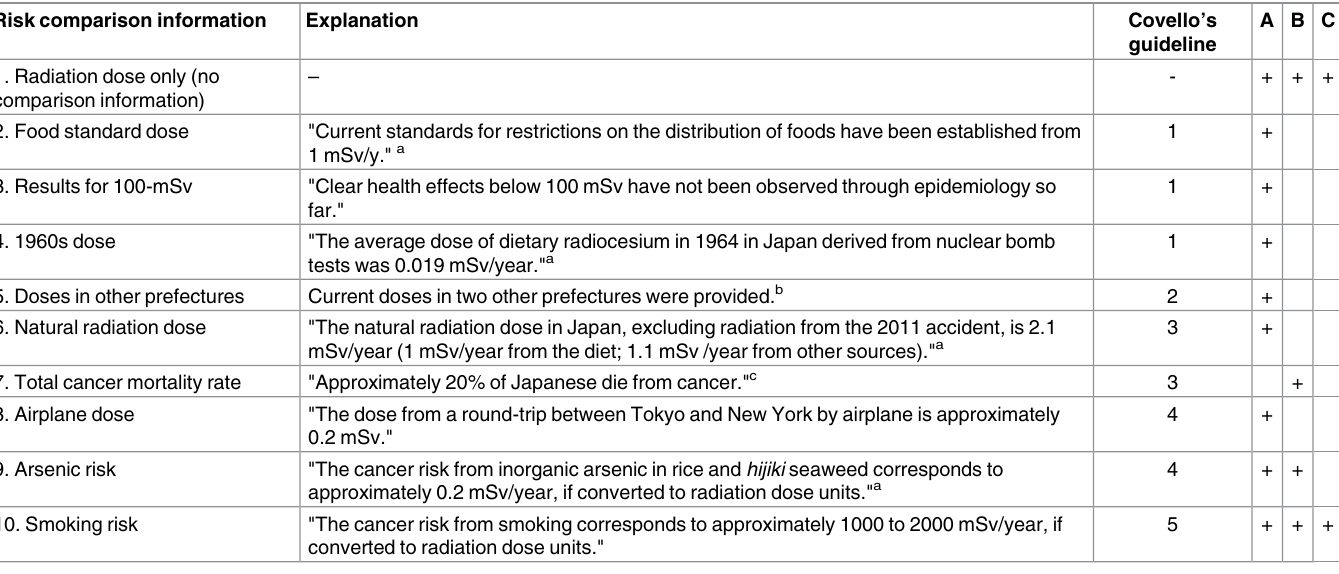
Table 3. Risk-comparison information provided, and its explanation. “+” represents risk-comparison information used in this